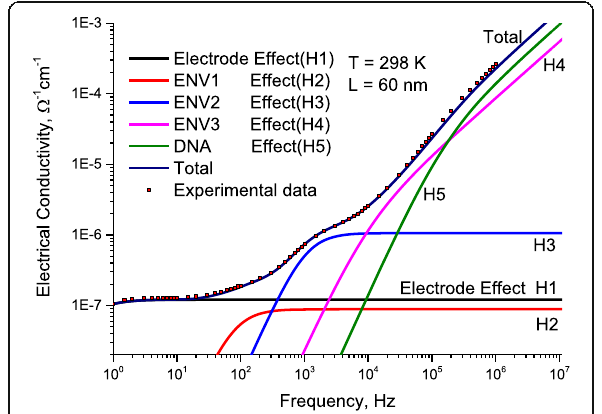
Fig. 13 At 298 K, the measured AC-conductivity as a function of frequency for DNA molecule as a function of applied frequency, lines represent calculated values after Eq. (12) with the data in Figs. 8 and 9. Symbols represent experimental values. There are five humps marked as H1, H2, H3, H4, and H5